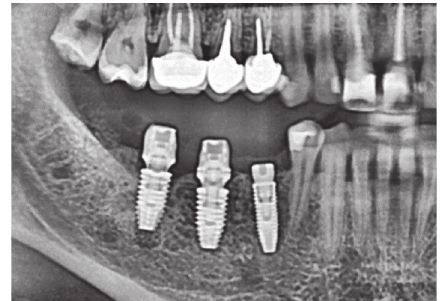
Figure 15: Formation of the bone